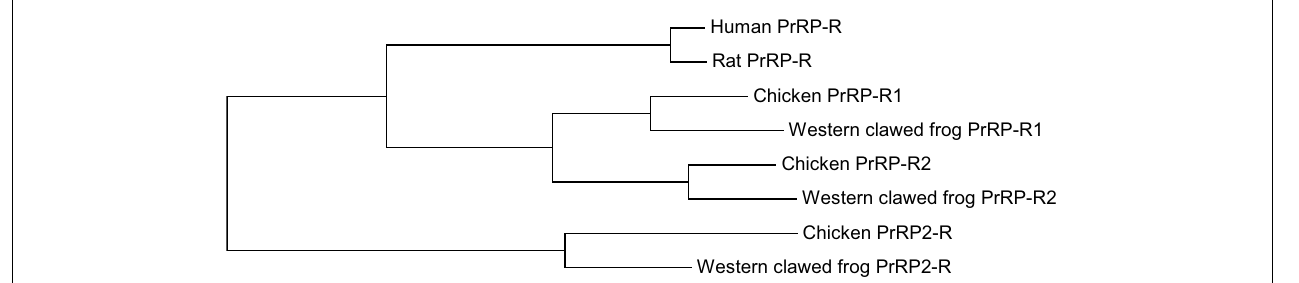
FIGURE 3 | Phylogenetic relationship between PrRP-R, PrRP-R1, PrRP-R2, and PrRP2-R in vertebrates .The tree was constructed using the maximum likelihood method, plotted in MEGA6.